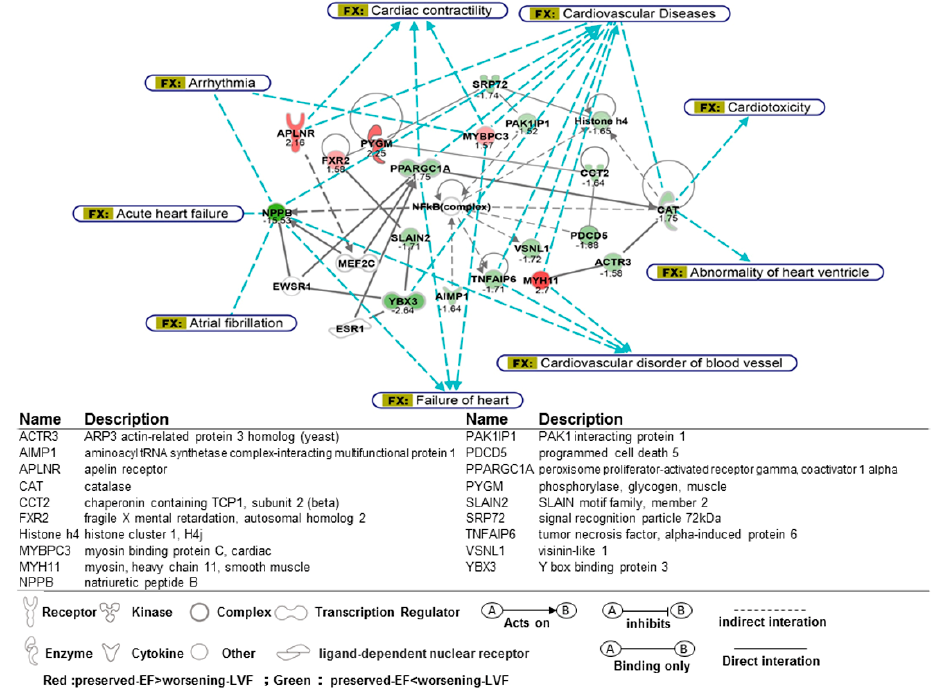
Figure 3. Network analysis for differentially expressed genes between worsening-LVF and preserved-LVF related to cardiovascular dysfunction and cardiac arrhythmia. A glossary for the gene symbols is shown in the lower panel. Red color indicates preserved-LVF > worsening-LVF. Green color indicates preserved LVF < worsening-LVF. Numbers represent fold-change.